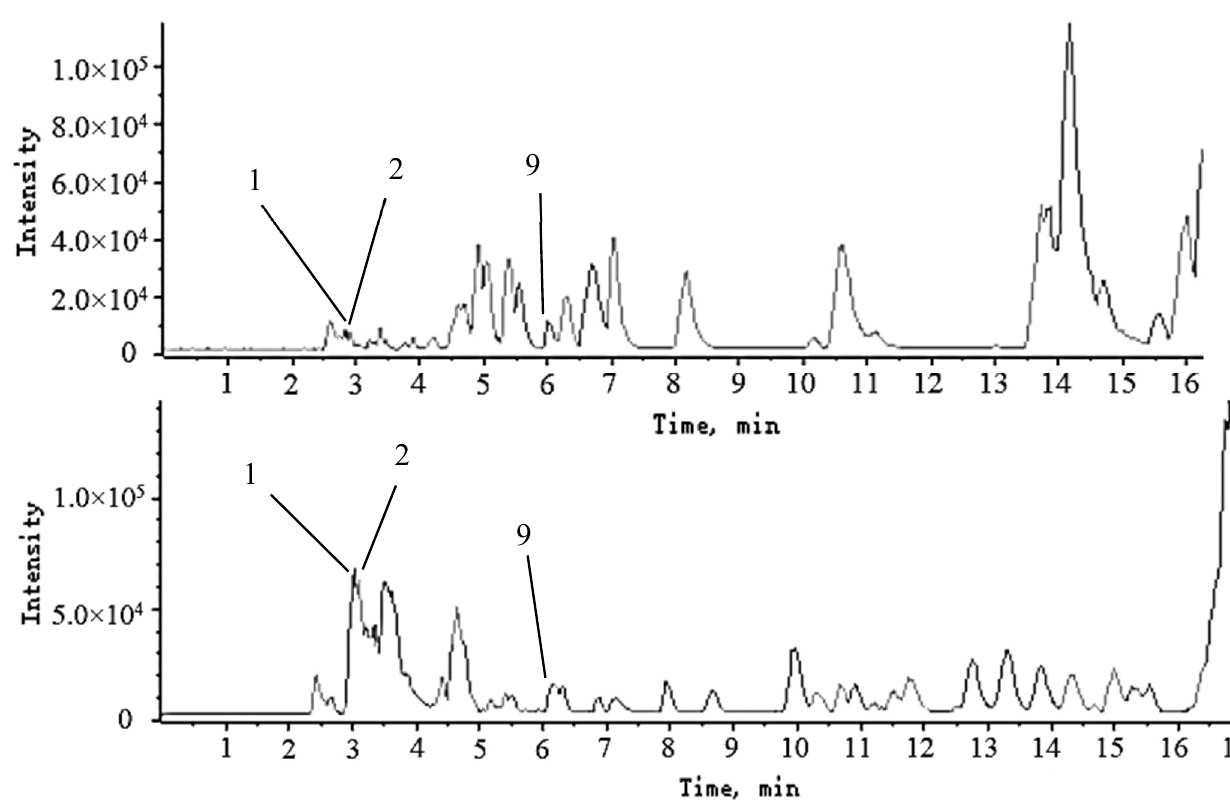
Figure 5. The base peak chromatogram (BPC) of part of the mixed standard solution ( a ) and the sample from Sichuan Deyang ( b ); ( 1 ) threonine, ( 2 ) glutamic acid, ( 9 ) phenylalanine.